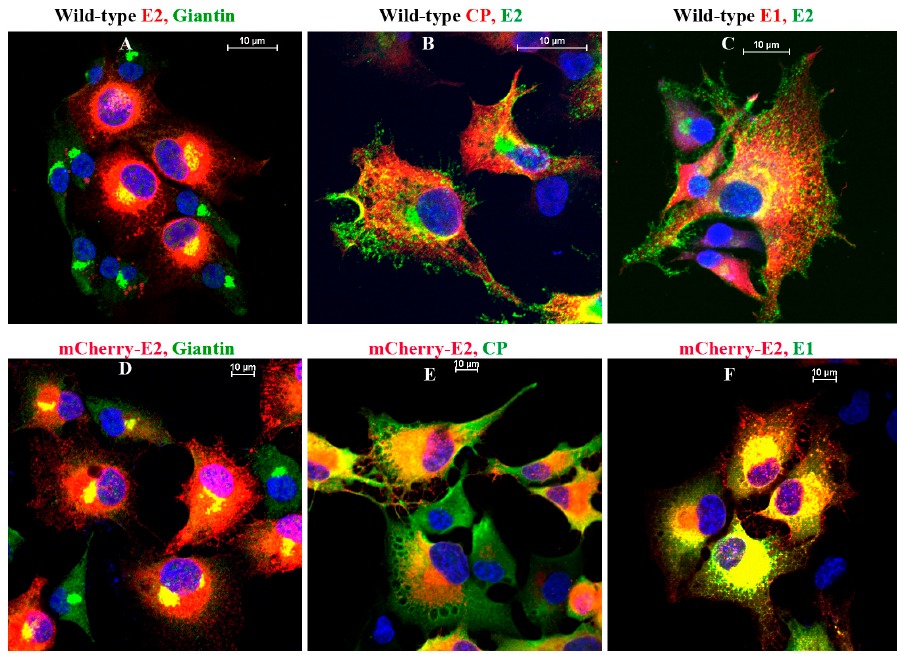
Figure 5. Immunofluorescence (IF) analysis of WT ( A – C ) and mCherry ‐ E2 virus ‐ infected BHK cells ( D – F ) showing the distribution of viral proteins. Cells infected with WT or mCherry ‐ E2 viruses were subjected to IF analysis at 6 h p.i. with antibodies against rabbit polyclonal Giantin (Golgi), rabbit polyclonal anti ‐ CP, rabbit polyclonal anti ‐ E1, and mouse monoclonal anti ‐ E2 primary antibodies and labeled with fluorescein isothiocyanate (FITC) ‐ or tetramethylrhodamine (TRITC) ‐ labeled goat anti ‐ rabbit and goat anti ‐ mouse secondary antibodies. BHK cells transfected with an mCherry ‐ E2 tagged E1 fusion loop mutant (G91D) showed that particles released from transfected cells can enter uninfected neighboring cells, but they appear unable to fuse within the cell to initiate a productive infection (Video S4). The association of mCherry ‐ E2 with Golgi was analyzed in live imaging using BODIPY FL C5 ceramide (Figure 6 ‐ 3) which stains Golgi (Videos S5A and S5B). Additionally, virus budding in close association with filopodial extensions and fluorescent single ‐ particle trafficking between two cells was observed (Figure 6 ‐ 3 panels a–e and Video S5B) in the stained cells (green). Furthermore, low pH treatment of FP ‐ tagged, virus ‐ infected BHK cells confirmed that the budded virions were present outside the filopodial extensions. At neutral pH, viruses were present outside the PM of filopodial extensions and were released into the media (Figure 6 ‐ 4 panels A and B). Low pH treatment of BHK cells infected with FP ‐ tagged virus showed that the budded virions retained the fluorescence and stayed attached to the filopodia after fusing to the PM at pH 5 (Figure 6 ‐ 4 panels C and D). When cells were treated at pH 4, the fluorescent signals were lost from the fused virions on the filopodia as well as the glycoprotein spikes present on the PM while the fluorescence was retained for the mCherry ‐ E2 present within the cells (Figure 6 ‐ 4 panels E and F).